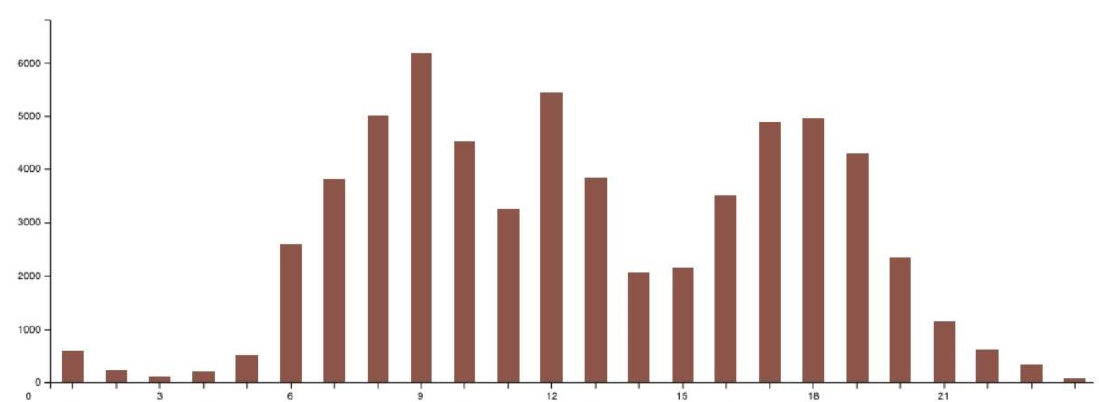
Figure 5. Distribution of minutes of running against time of day for all